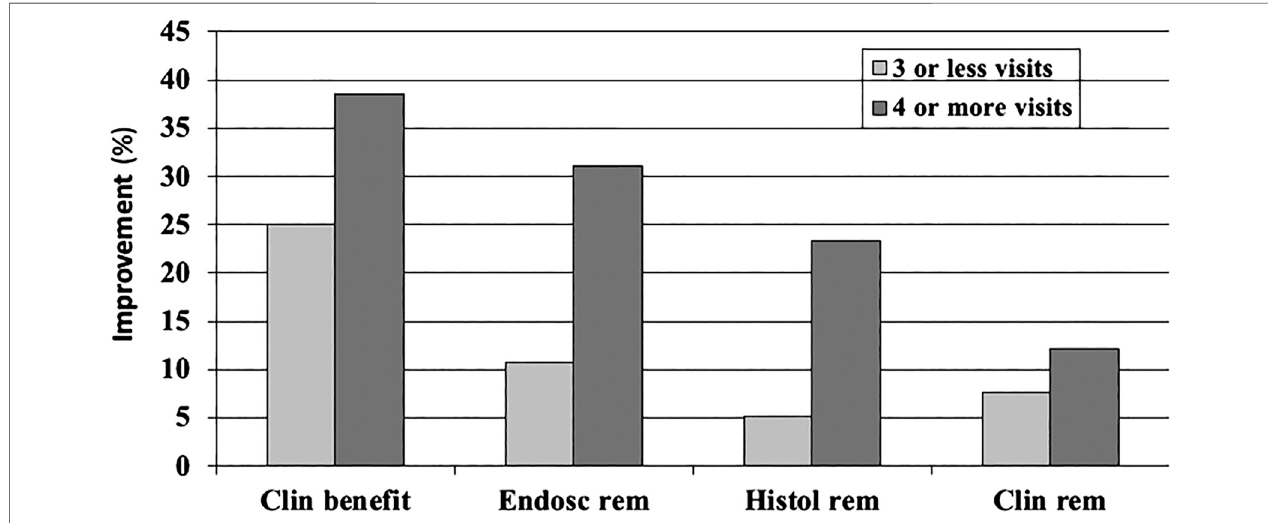
FIGURE2| Dose-dependentfunction ofthe(pooled,%) placebo response inameta-analysisofrandomized and placebo-controlledtrials (RCT) inulcerativecolitis (22): the number of doctor visits during the trial has an effect on all clinical outcome parameters, clinical bene fi t (improvement), endoscopically assessed remission, histologically assessed remission, and clinical remission measures.